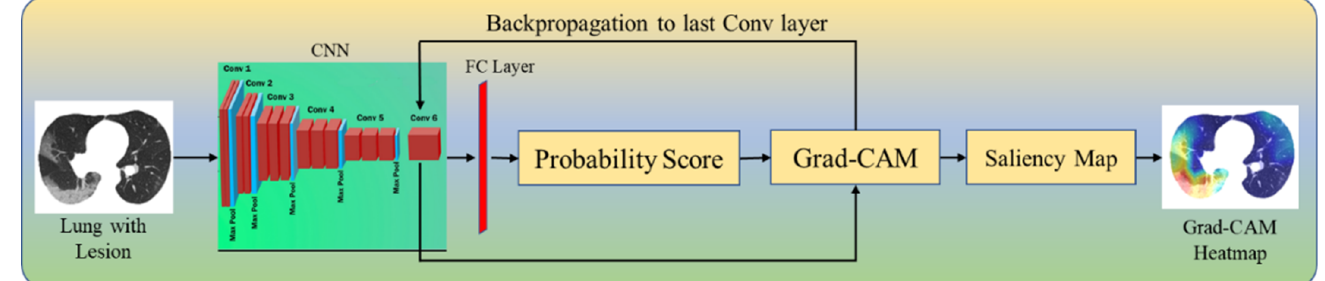
Figure 5. Grad-CAM. Figure 5. Grad-CAM.